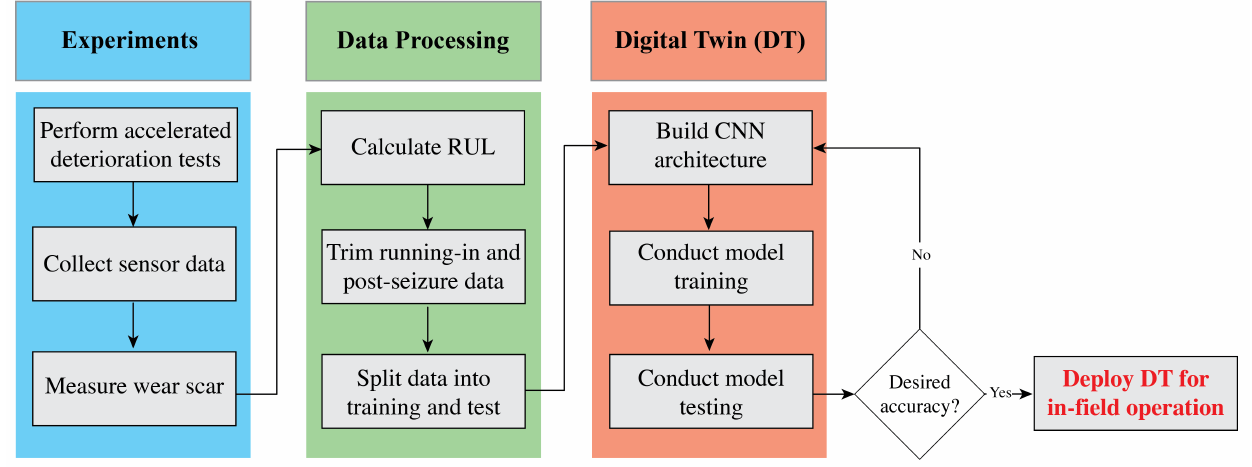
Figure 2. Research methodology used in the present